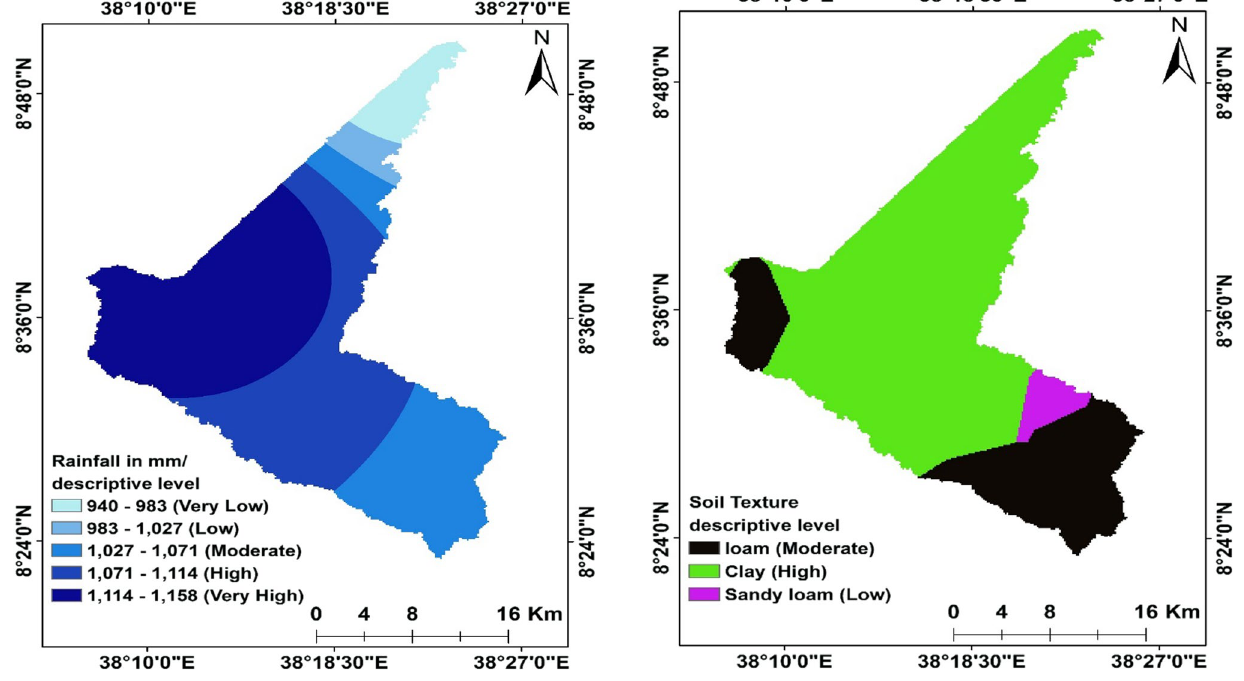
Figure 7 Rainfall distribution map of the study area Figure 8 Soil texture map of the study